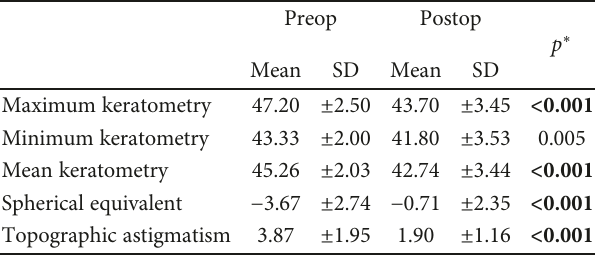
Figure 2: Preoperative and postoperative corneal topography after ICRS implantation. Table 1: Preoperative and postoperative data after ICRS